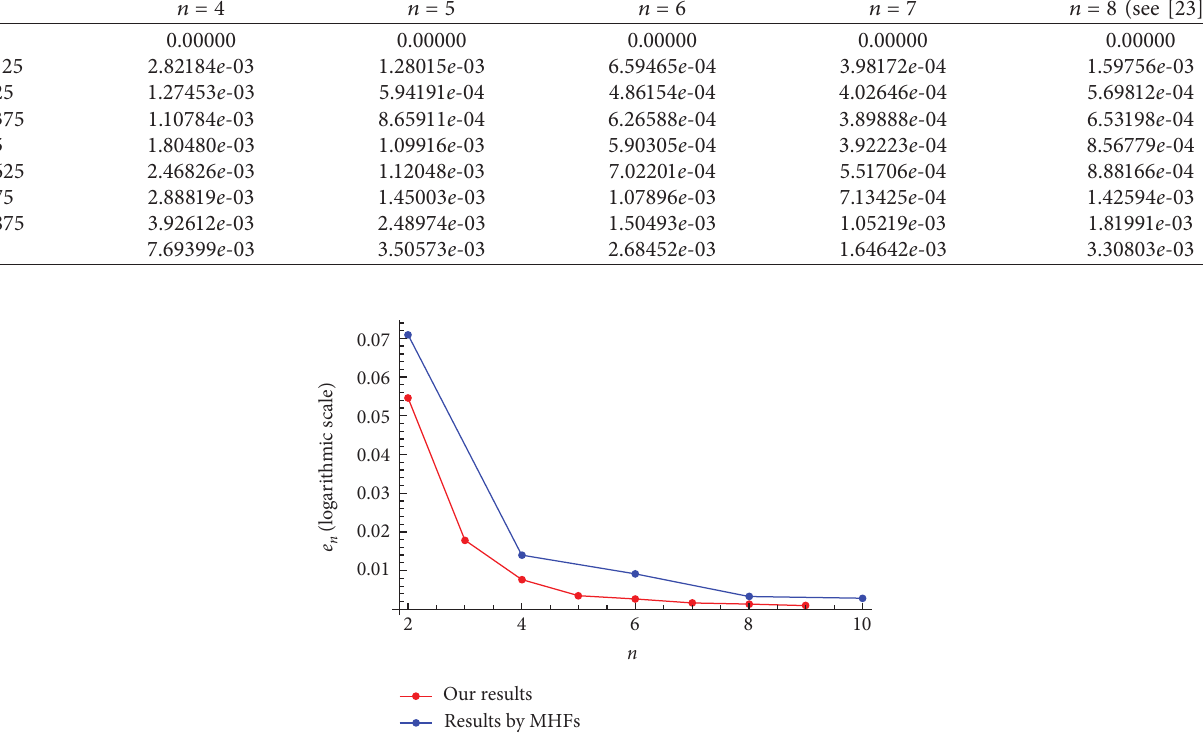
Figure 1: e n on logarithmic scale for different methods (Example 1). Table 2: The absolute errors with different n for Example 2 ( α � 1 ) .